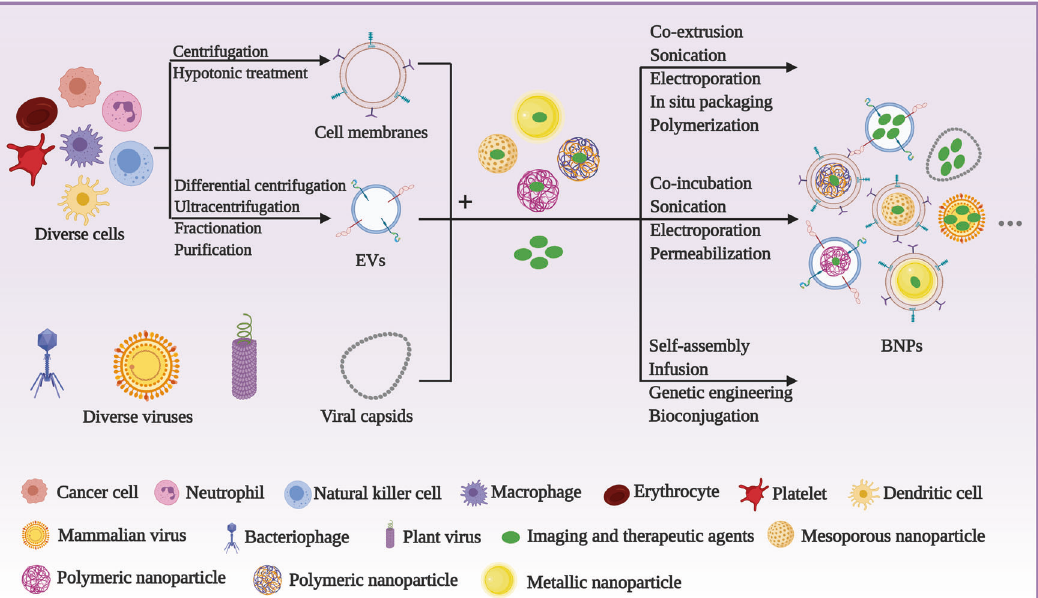
Fig. 1 Schematic depicting the typical procedures to construct various BNPs. Both cell membranes and EVs derived from diverse cell types can be obtained, whereas diverse viruses and their capsids serve as vectors directly or indirectly. These biological vectors interact with drug- loaded synthetic nanoparticles or functional agents to form BNPs via multiple methods